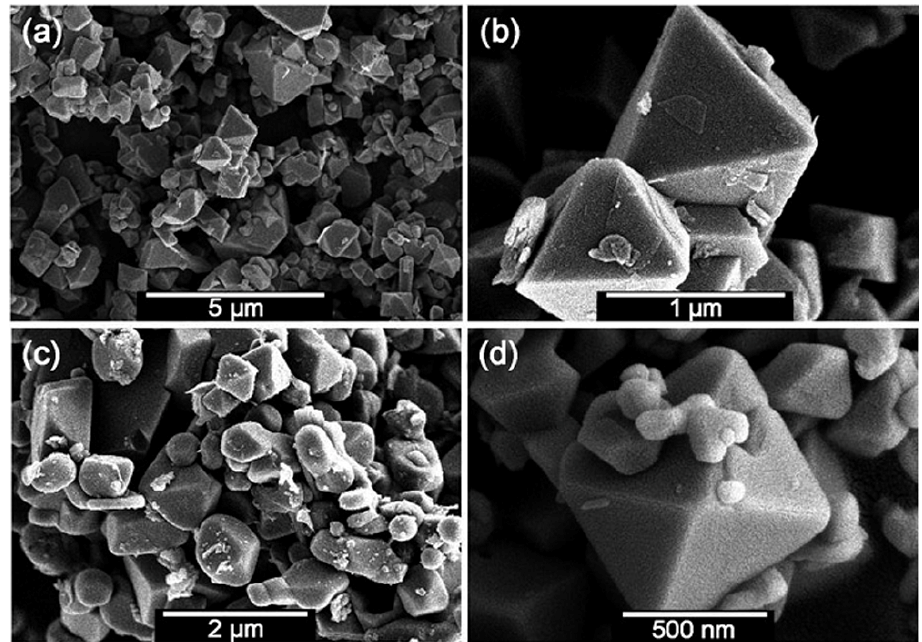
Figure 10. Typical SEM images for CrN crystals prepared at 5 GPa and 1200 °C for 20 min ( a ) with an enlarged fragment shown in ( b ), at 3 GPa and 1200 °C for 20 min ( c ), and at atmospheric pressure and 1000 °C for 2 h in Ar gas ( d ). Reprinted with permission from Chen et al., Chem.: Eur. J. 18, 15459-15463 (2012). Copyright 2012 John Wiley and Sons, Inc. (Ref. 12).